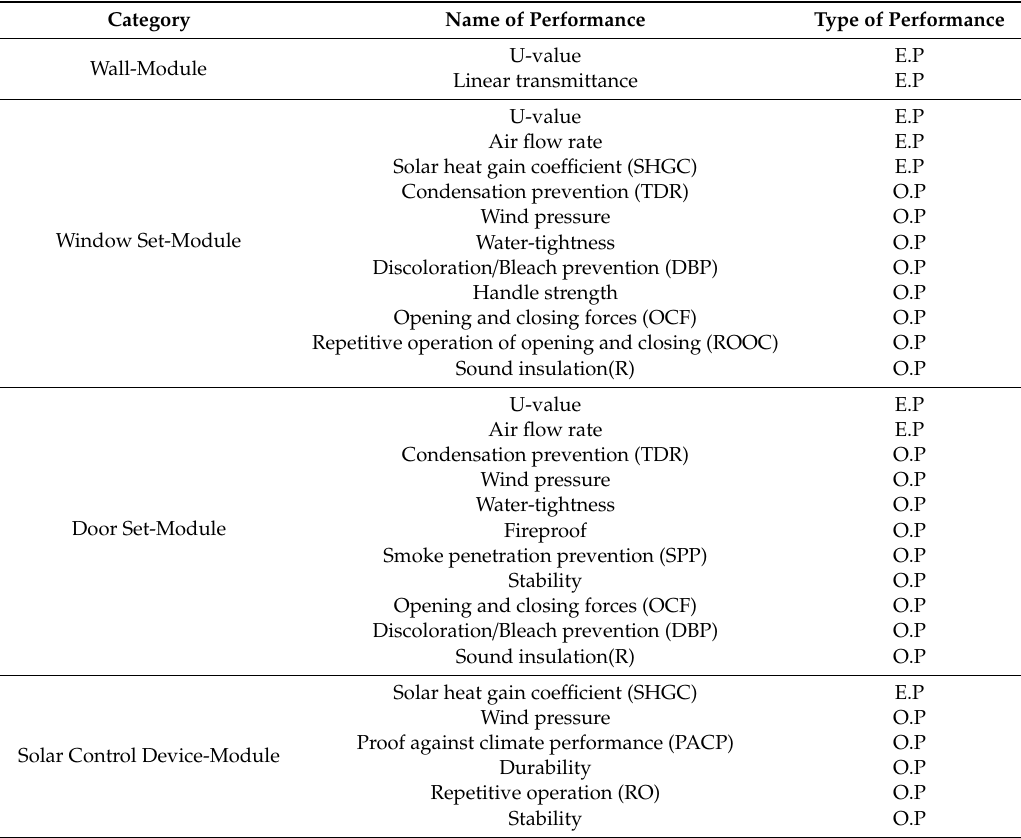
Table 3. Module performance